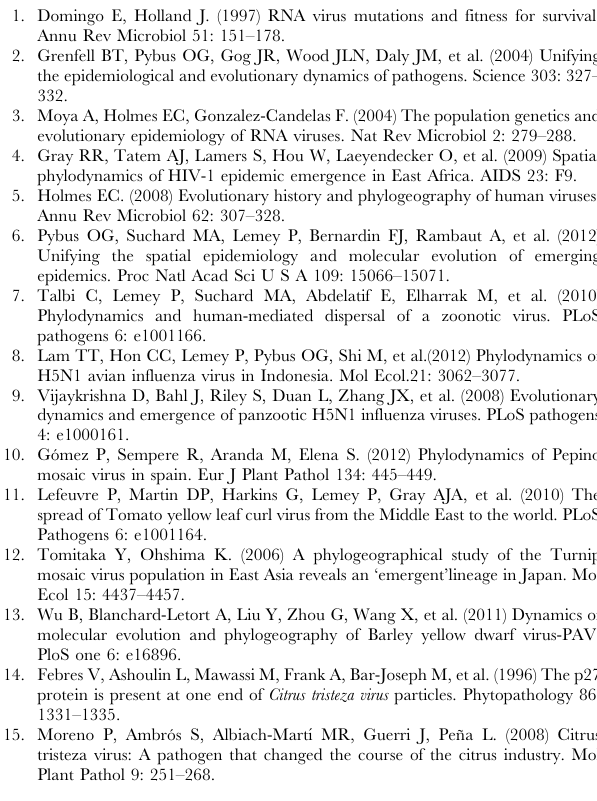
Figure S1 Bayesian phylogenetic tree drawn for the p20 gene from 108 CTV isolates from Sicily (sequenced in this work; highlighted in gray) plus 116 worldwide CTV isolates (from GenBank). Node significances are indicated by Bayesian posterior probabilities. Phylogenetic clades with Sicilian isolates are indicated as A, B, C, D and